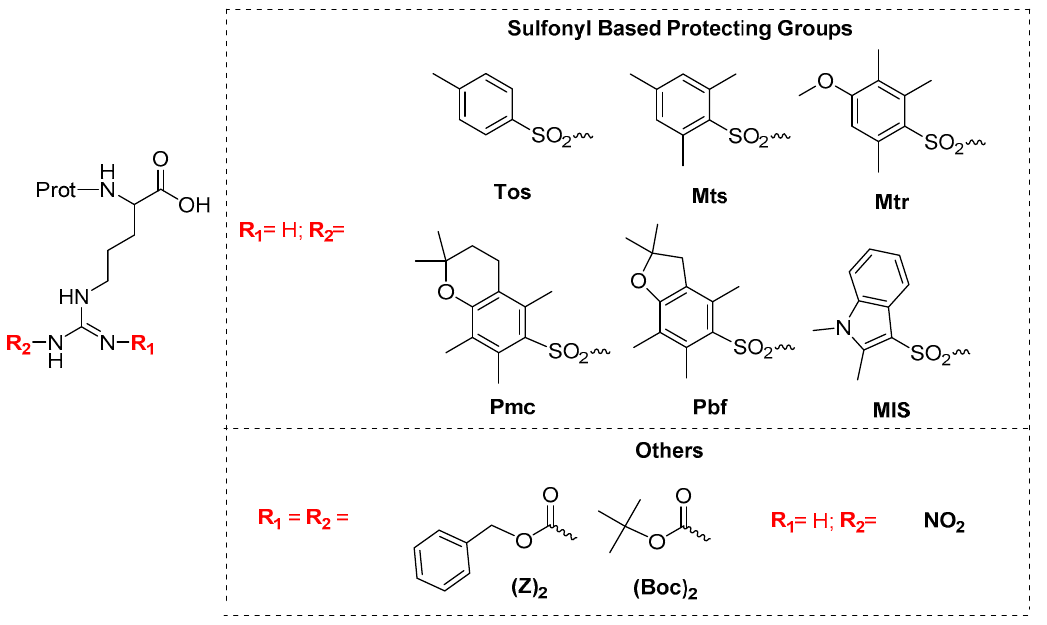
Figure 1. Most used Arg side-chain protecting groups.